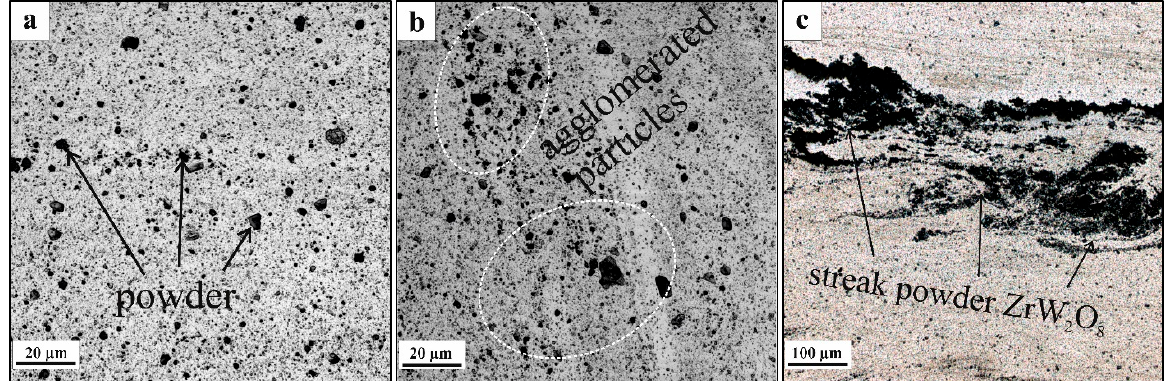
Figure 7. Microstructure of the FSP-ed RPPs/AA5056 composites after 4 passes: ( a ) stir zone, ( b ) thermomechanically affected zone; ( c ) subsurface RPP accumulation layer.